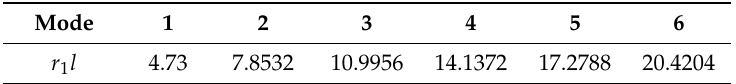
Table 1. First six solutions of r 1 l for fixed-fixed double-beam